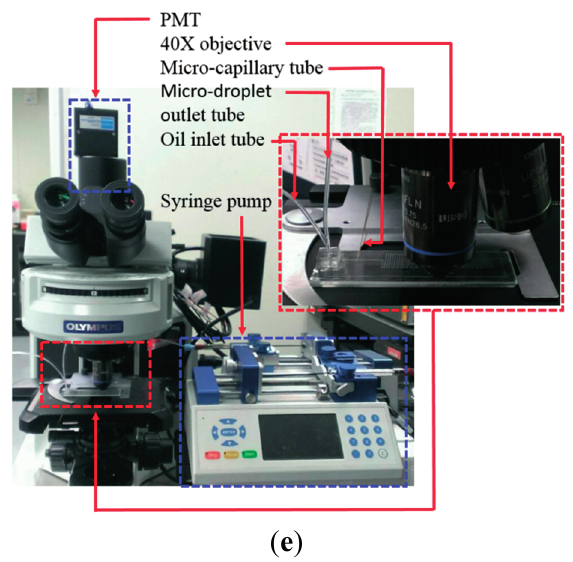
Figure 1. ( a ) Schematic illustration of the microfluidic device (Top-view layout); ( b ) The photographs of the continuous micro-droplet generation process ((I)-(IV)); ( c ) Schematic illustration of the assembly of the microfluidic device ((I)-(III): microfabricated PDMS layers, (IV): micro-capillary tube, (V): glass layer); ( d ) schematic illustration; and ( e ) photograph of overall experimental